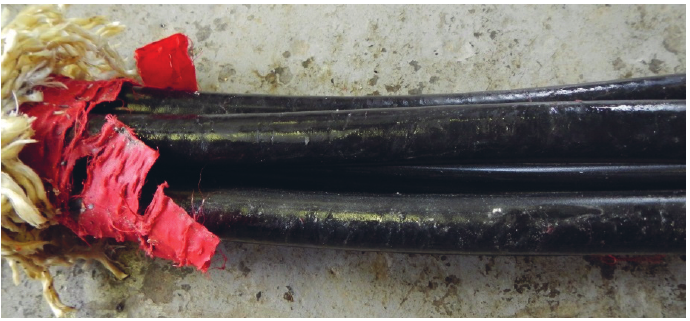
Figure 19. Minor compression deformations on the outer surface of the tether core strands.